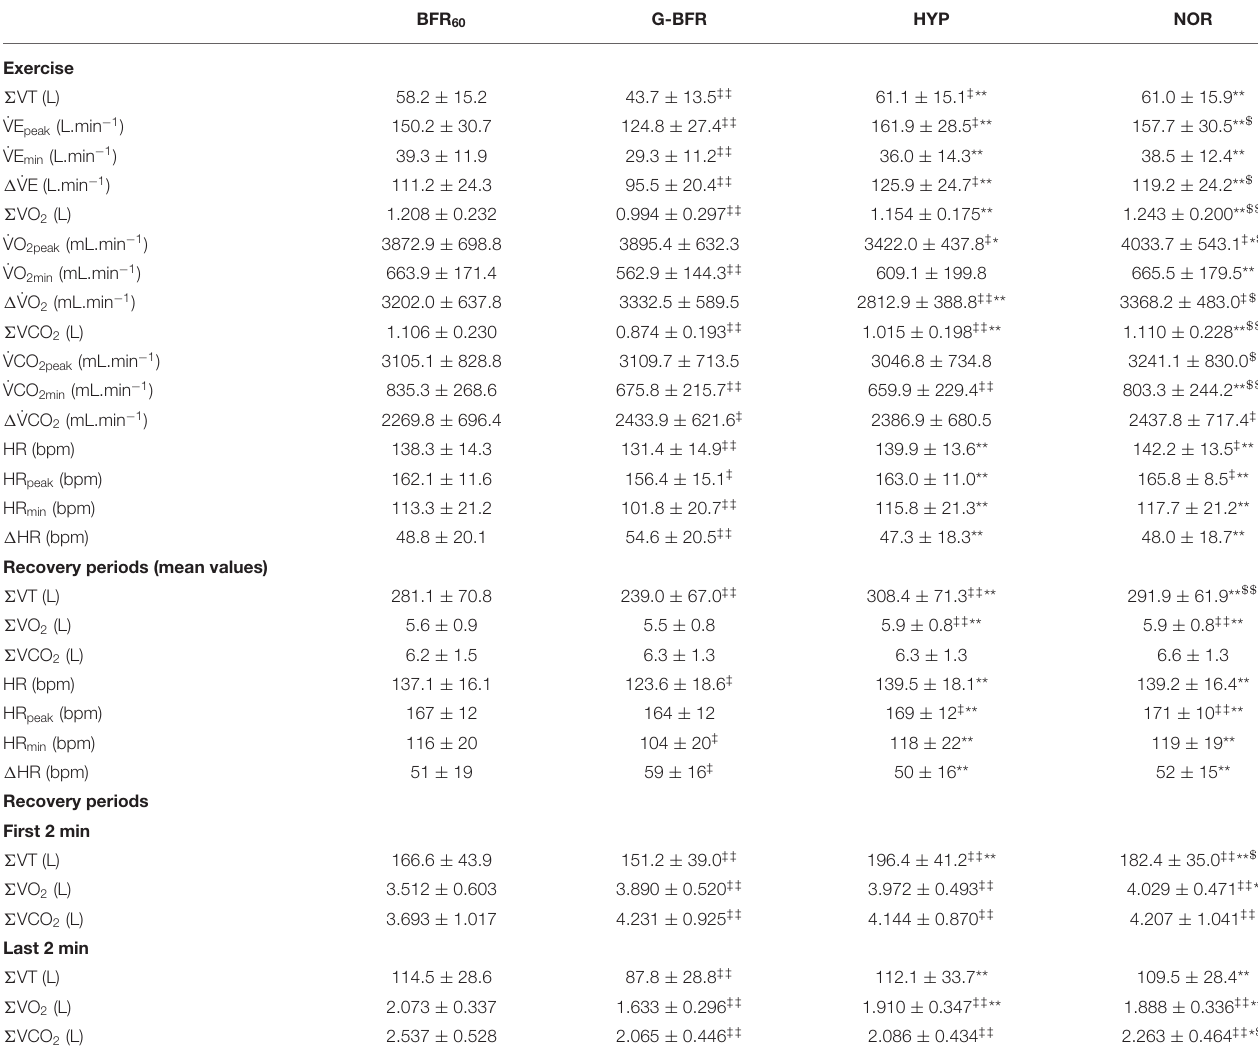
TABLE 1 | Cardio-respiratory responses during the